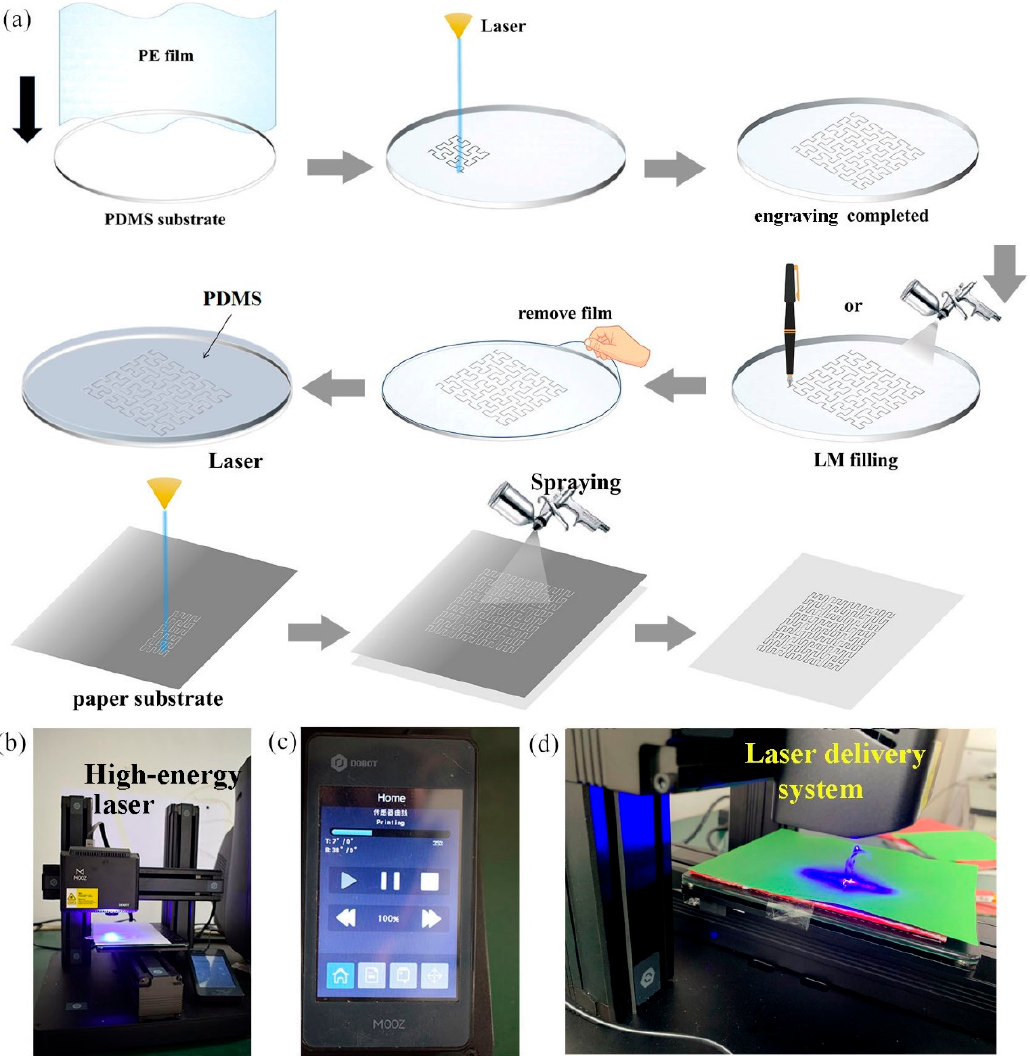
Figure 1. ( a ) Steps for the laser engraving of an LM circuit onto a PDMS substrate and the steps for the laser engraving of an LM circuit onto a paper substrate. ( b ) Photograph of the laser engraving of the PDMS substrate. ( c ) Display screen of the laser engraving equipment. ( d ) Photographs of the laser engraving of the paper substrate.